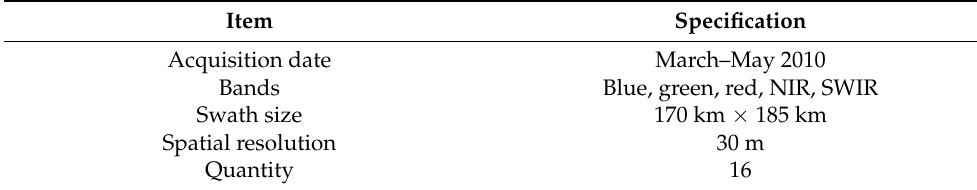
Table 2. Major characteristics of Landsat 7 data in our